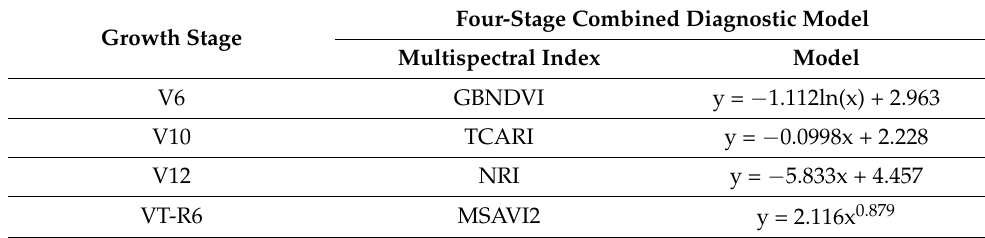
Table 6. A four-stage combined diagnostic model of nitrogen concentration in summer